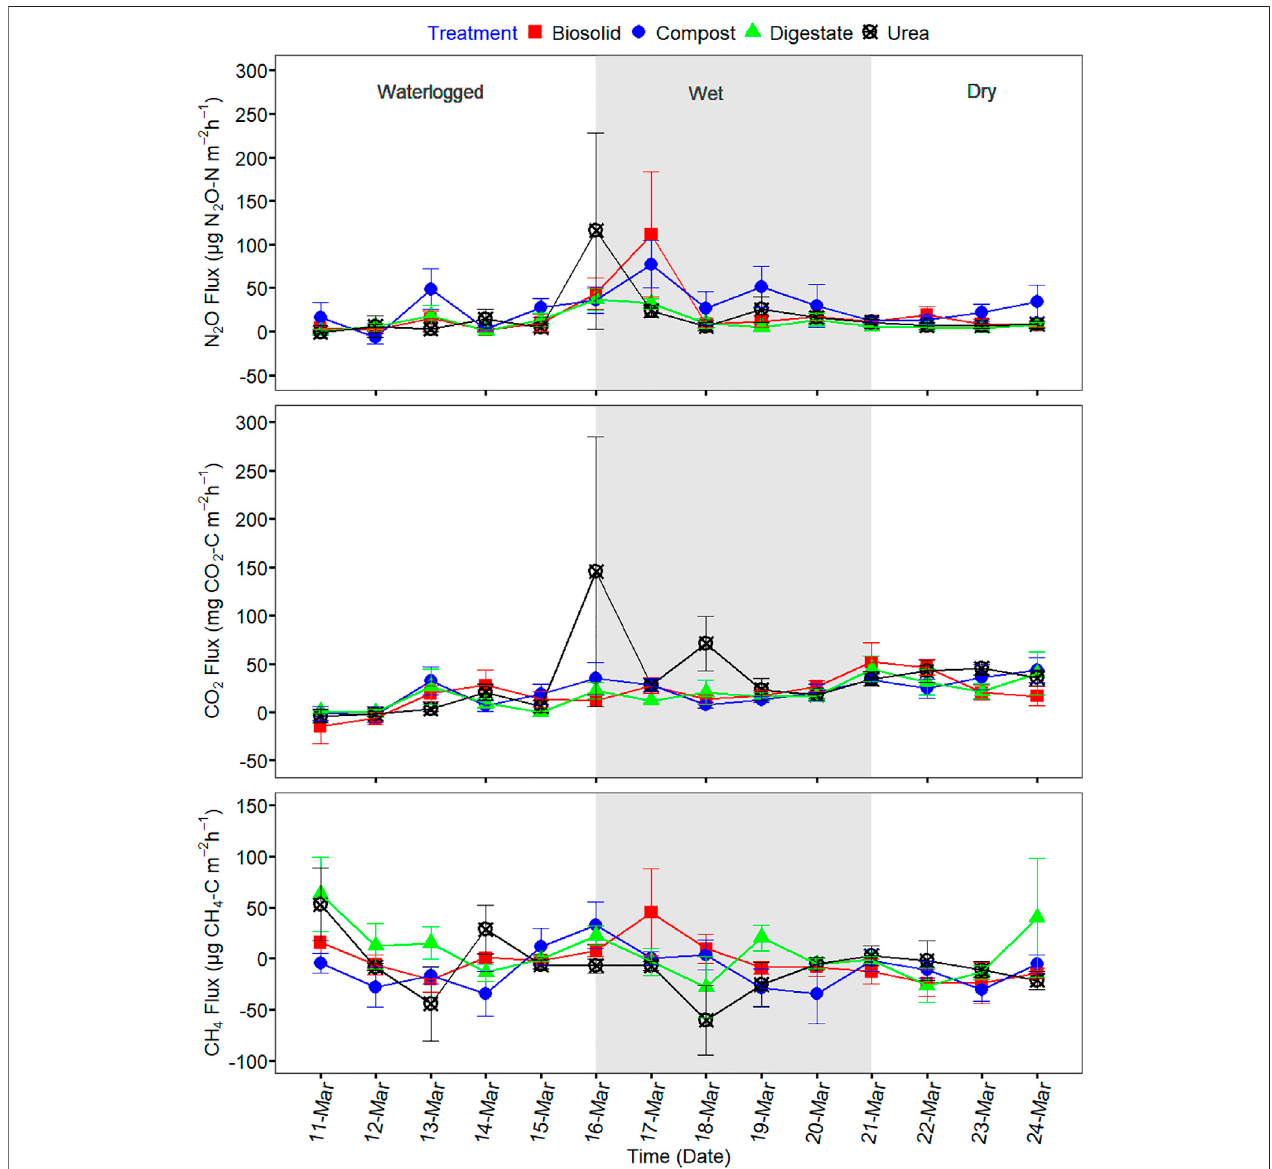
FIGURE 2 | Greenhouse gas fl uxes of N 2 O, CO 2 , and CH 4 during the spring freeze-thaw event of 11 March to 24 March 2021.